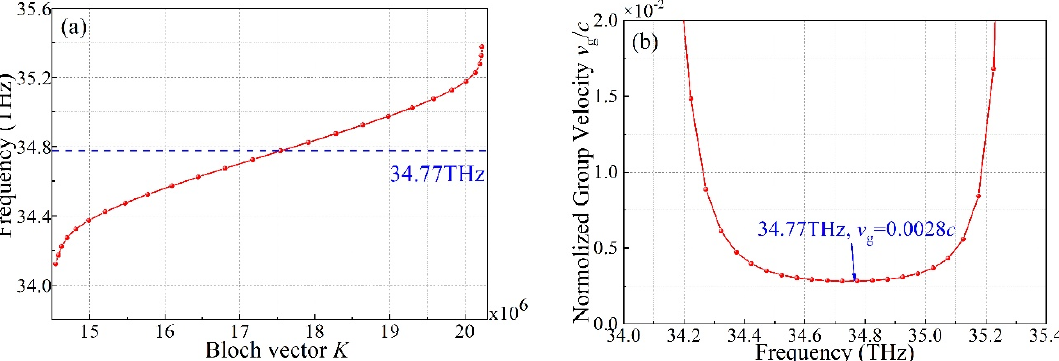
Figure 4. ( a ) Dispersion relationship of the graphene waveguide with bias voltage 60 V. ( b ) The normalized group velocity v g /c of SPPs propagating on interface of graphene waveguide with bias voltage 60 V.